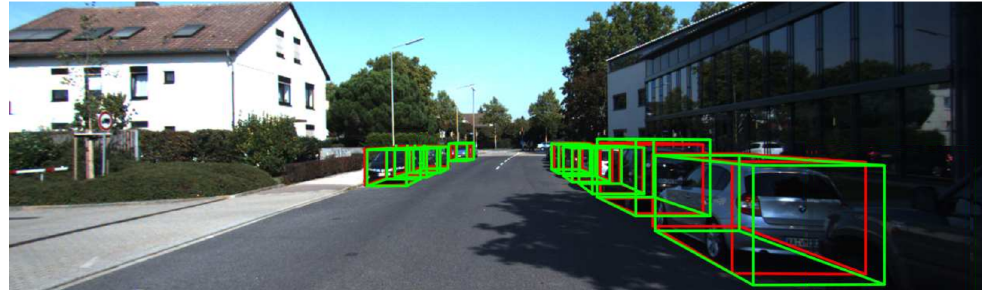
Figure 1. Example of a road scene where detection results using LiDAR technology is used. Detected objects are surrounded by bounding boxes. The green boxes represent detection while the red ones represent ground